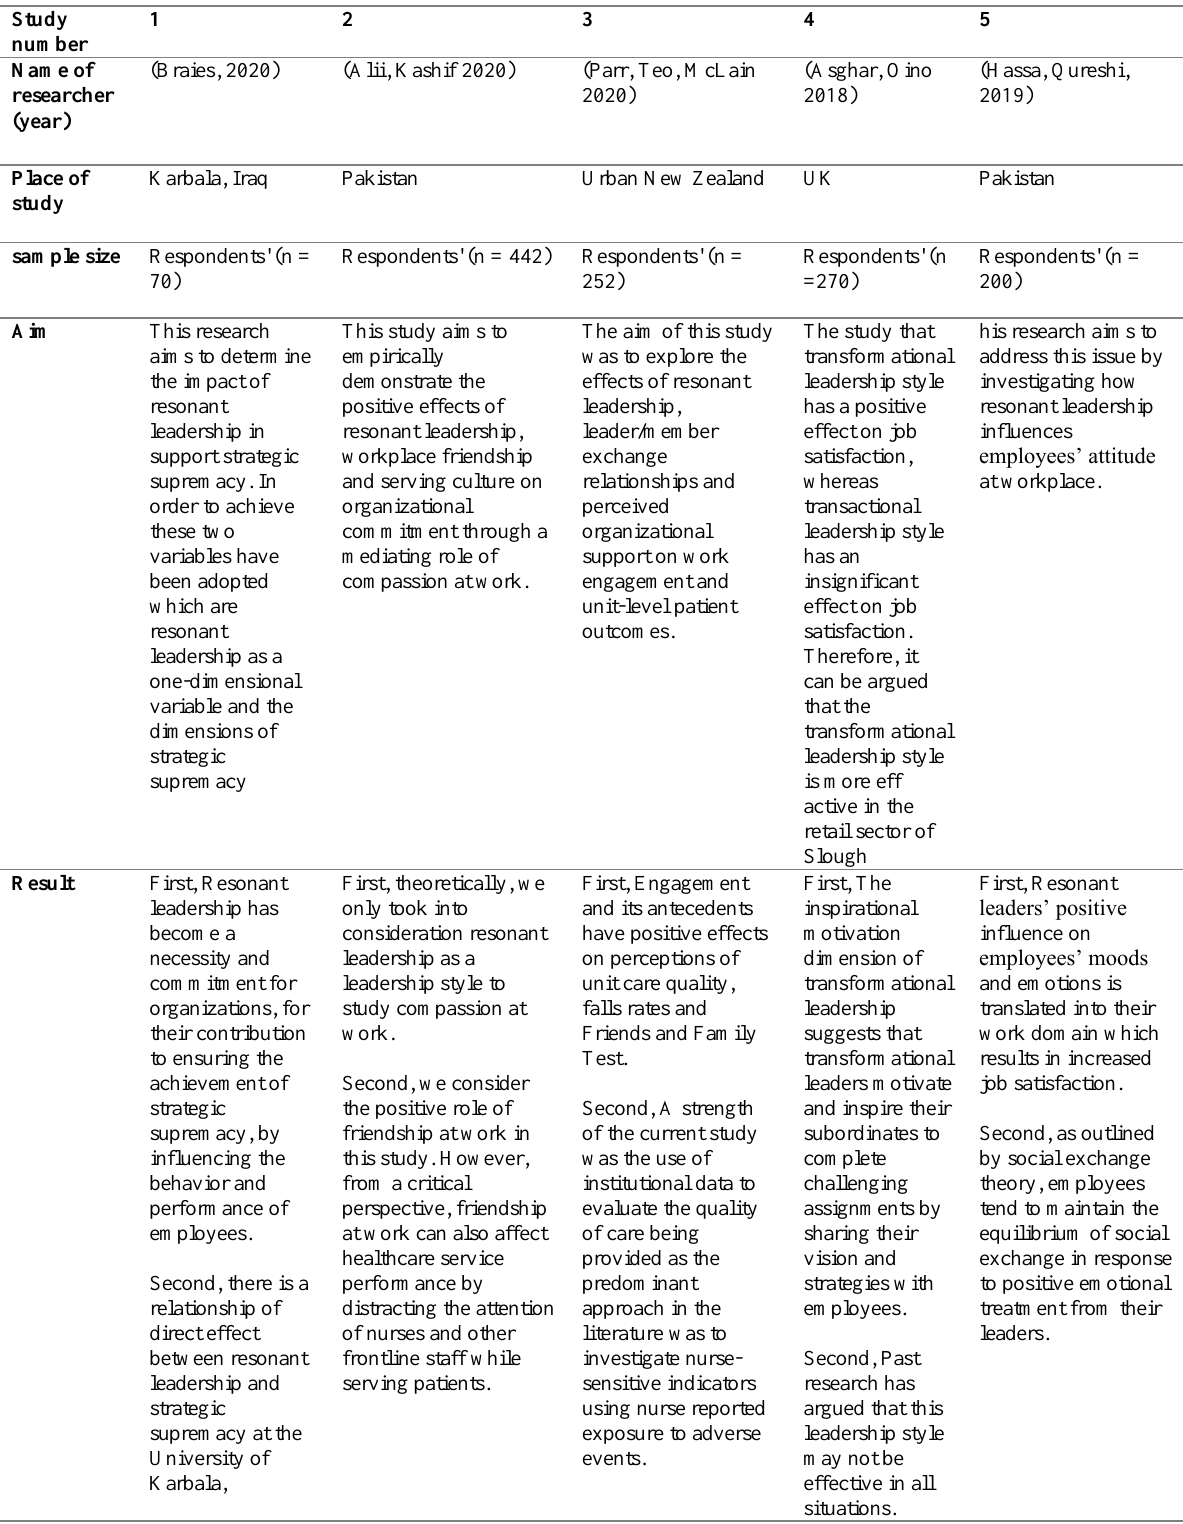
Table 1: Empirical studies for resonant